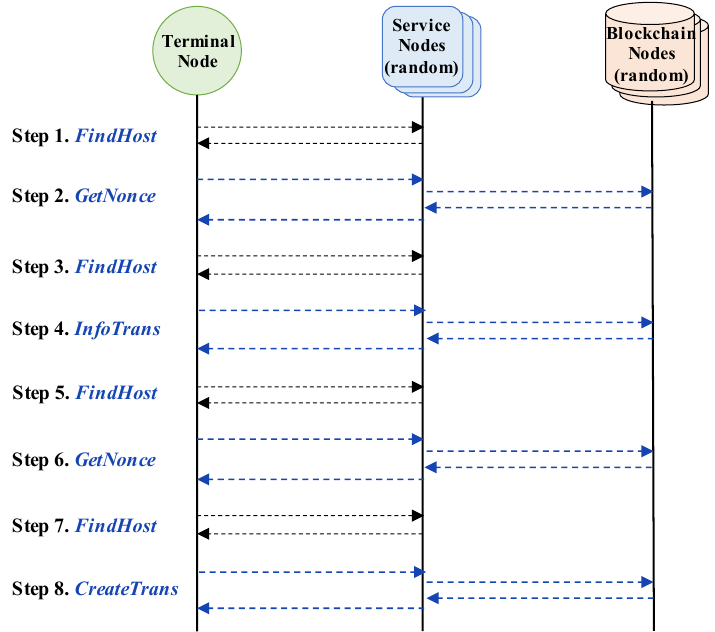
Figure 5. Detailed query steps of SendCoin